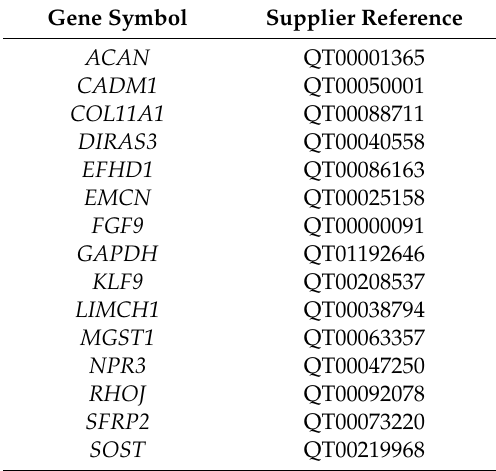
Table 1. qRT-PCR primers. Primer list and references are